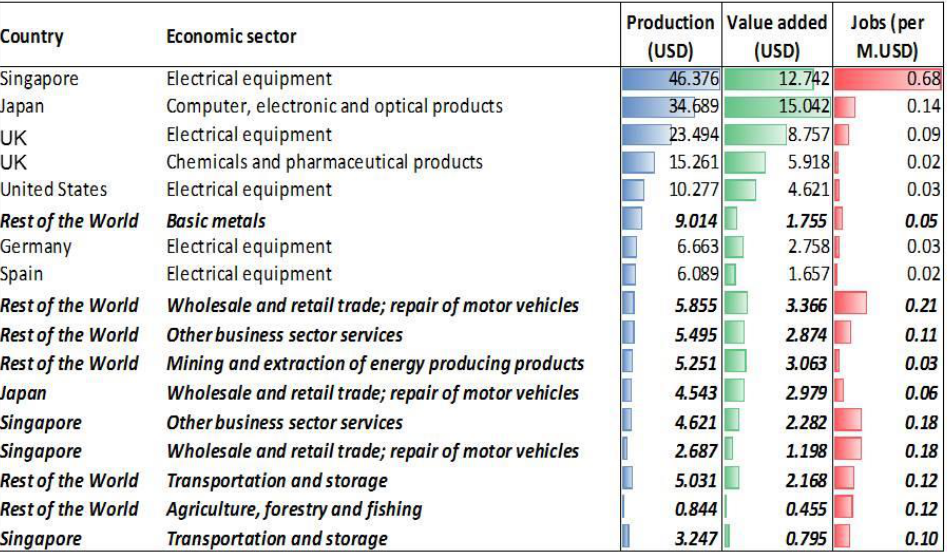
Figure 6. The main economic sectors responsible for the largest shares of socioeconomic effects.